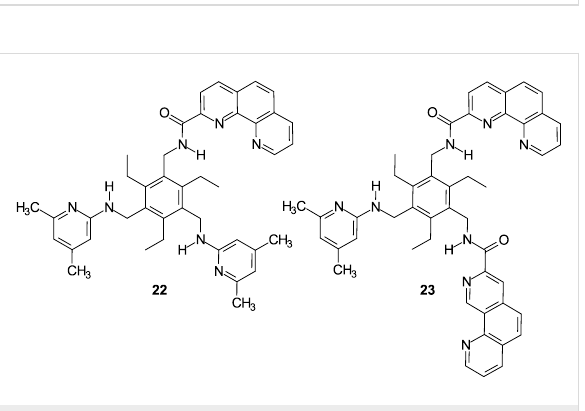
Figure 4: Structures of the recently described phenanthroline/ aminopyridine-based receptors showing α- vs. β-anomer binding pref- erences in the recognition of glycosides